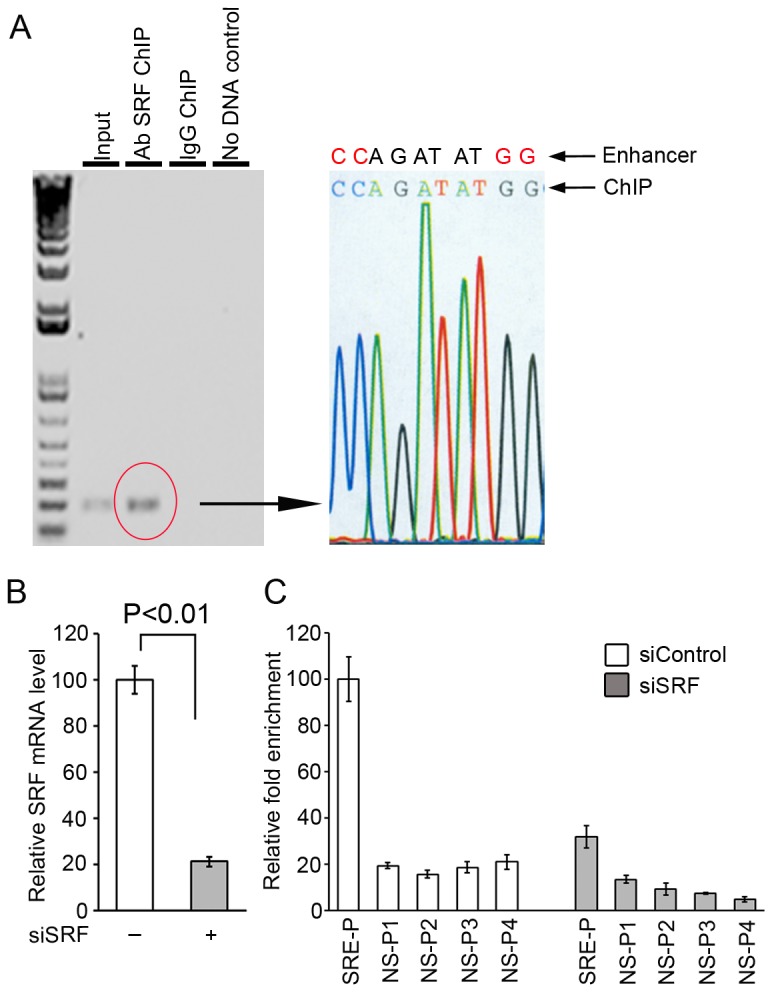
The putative SRE motif located in the intragenic enhancer of miR-1-1/133a-2 was verified by the chromatin immunoprecipitation (ChIP) assay with sequencing assessment in vivo.The cell chromatins were extracted from C2C12 cells transfected with either SRF expression vector or siRNA specific for SRF, and the SRF-SRE complexes were pulled down by the anti-SRF antibody. A. The oligonucleotides containing the SRF-binding site were detected (left panel). The PCR product was sequenced and the sequence matched with the enhancer (right panel). B. Quantitative PCR showed that SRF knockdown was achieved. C. Quantitative ChIP assays showed that loss of SRF resulted in decreases in the SRF-SRE complexes, and non-specific PCR primers failed to detect the SRE motif. SRE-P: specific primers for SRE; NS-P: non-specific primers upstream and downstream of the SRE site.